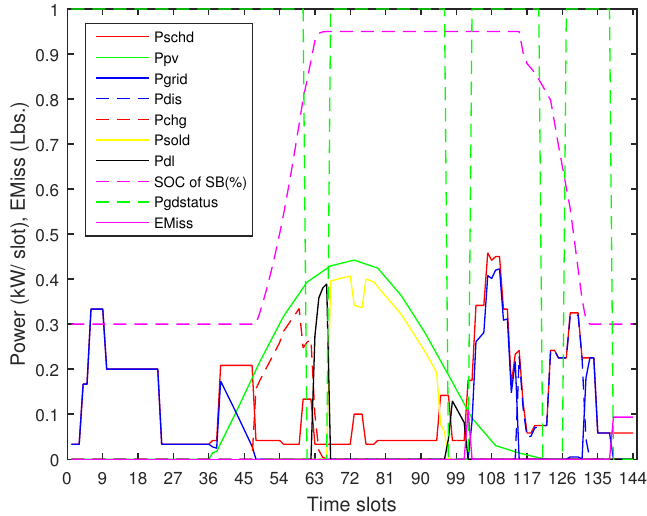
Figure 8. Power and emission profiles for DRSREODLDG-based HEMS operation for